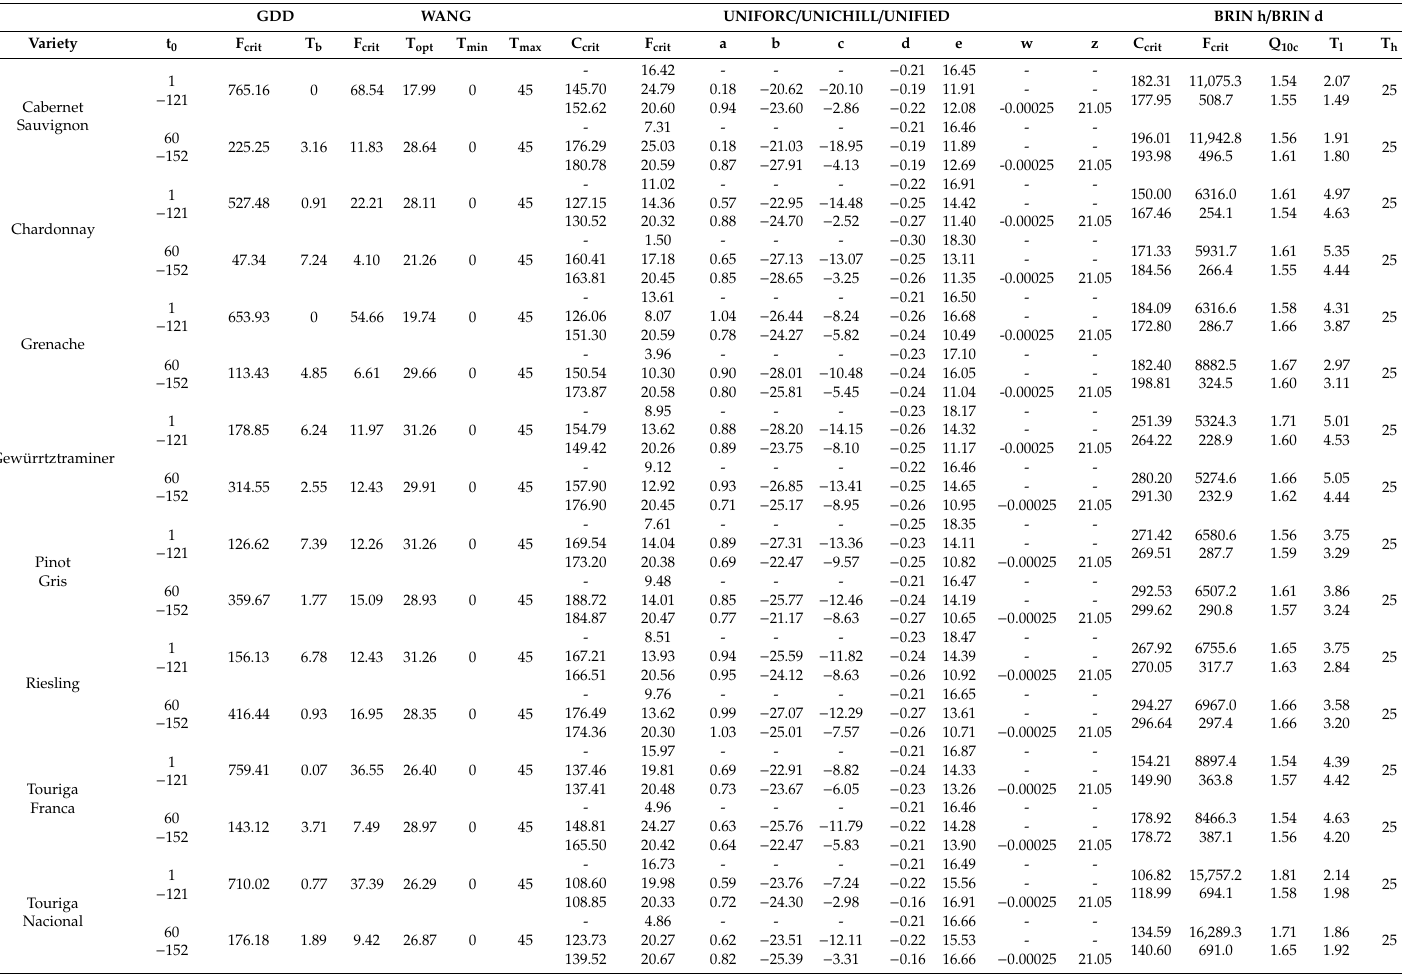
Table 3. AV (average) parameter sets for each combination of models, grapevine varieties and starting dates. C crit = critical amount of chilling and F crit = critical amount of forcing. GDD